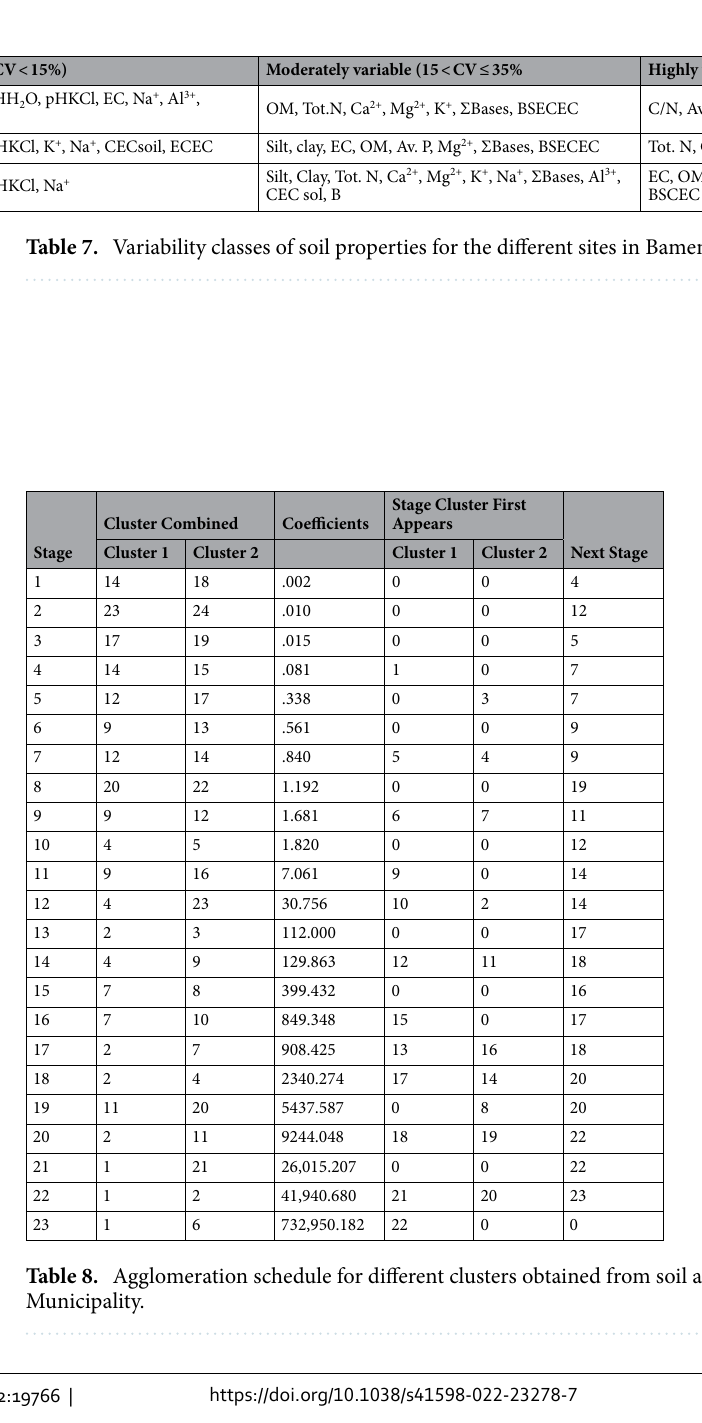
Table 6. Physicochemical properties of soils within the Urban, Peri-urban and Rural wetland sites of Bamenda Municipality, Cameroon.